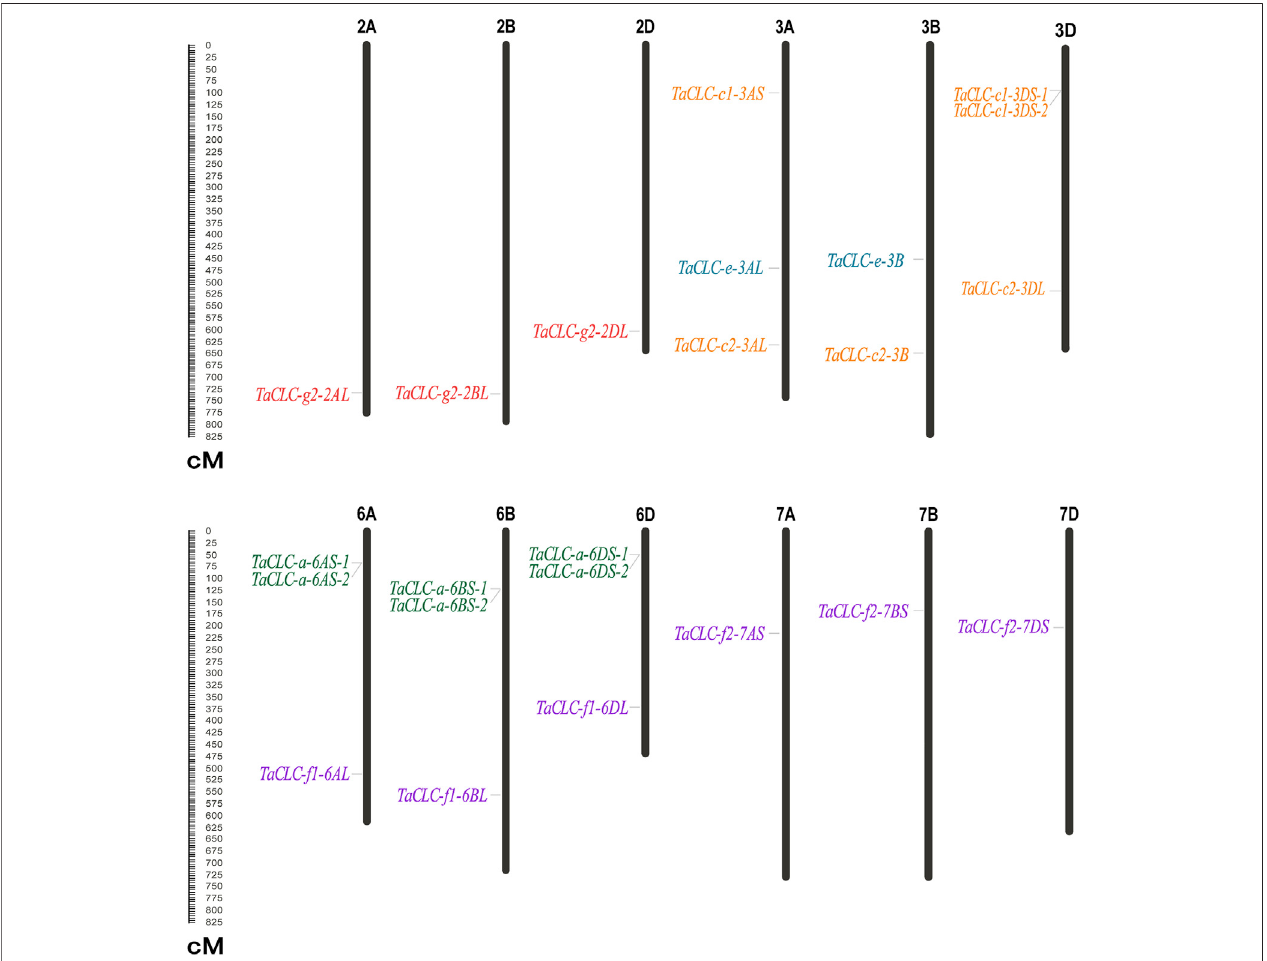
FIGURE 2 | Distribution of TaCLC genes on chromosomes. The names of each chromosome are shown above. The gene names are indicated on the left and the startingpositionsareontherightsideofthechromosomes.The TaCLC genesineach subfamilyarespeci fi edbythesamecolor.Thechromosomelengthsareshown in Mb (Millions of